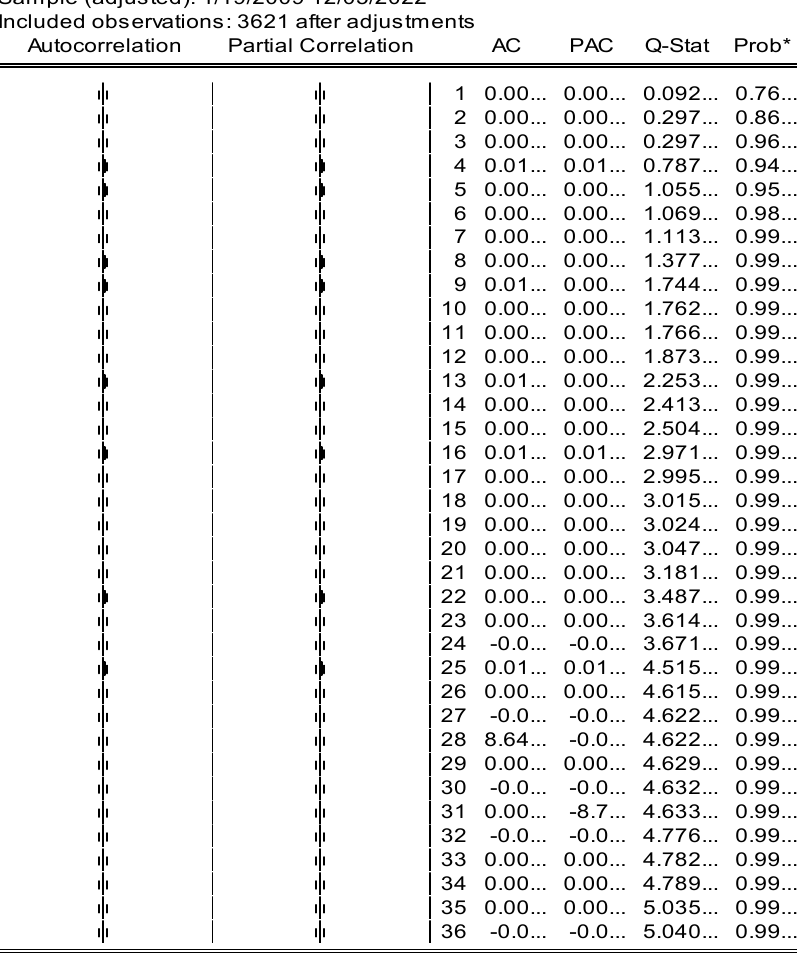
Figure 6. Correlogram plot of Squared Residuals. * indicates significant probability levels.